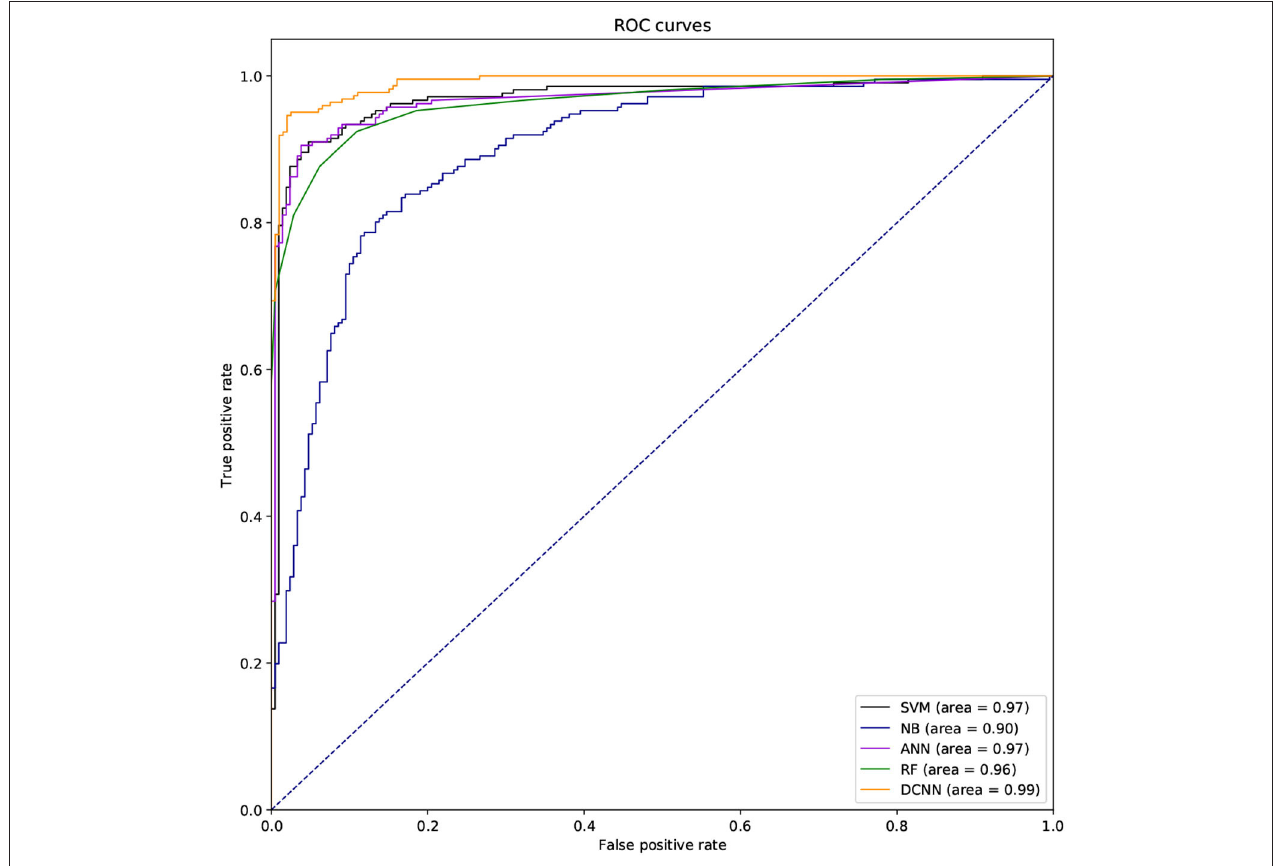
FIGURE 7 | The ROC curves of different